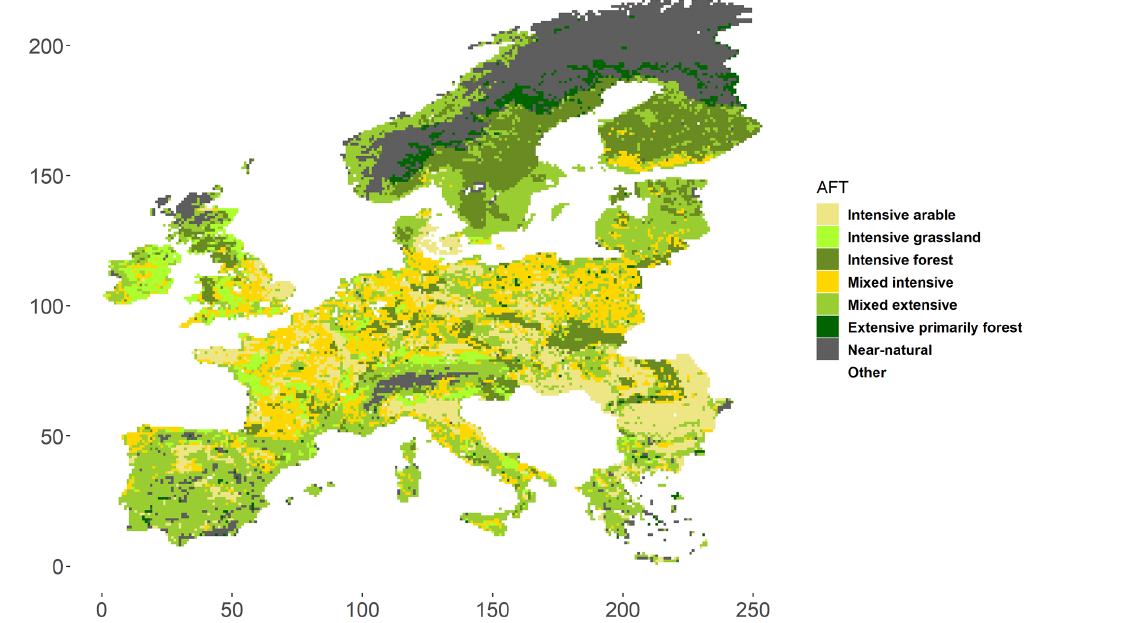
Figure A2. Baseline CRAFTY-EU land cover from which all main simulations begin. This baseline map is derived from that of the IAP, which is a modelled land use allocation on the basis of 1961–1990 average climatic conditions and 2010 socio-economic conditions.